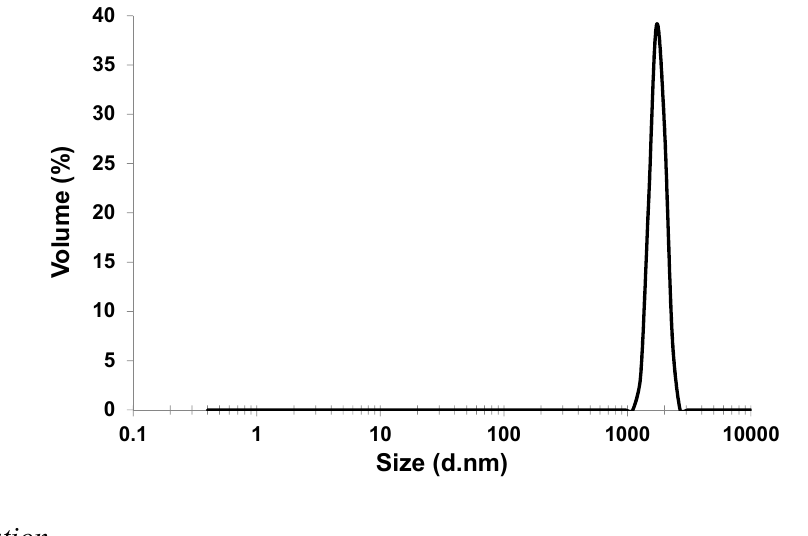
Figure 5. Zetasizer measured particle size distribution of the zeolite